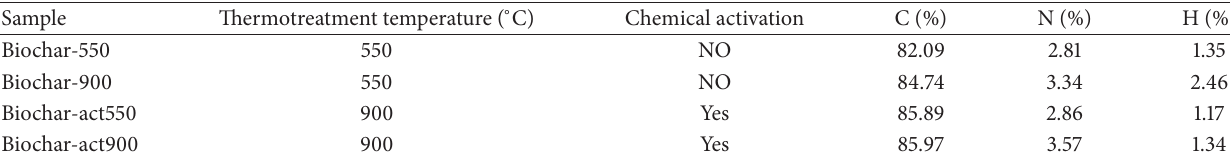
Table 2: The elements of biochars at different treatments.